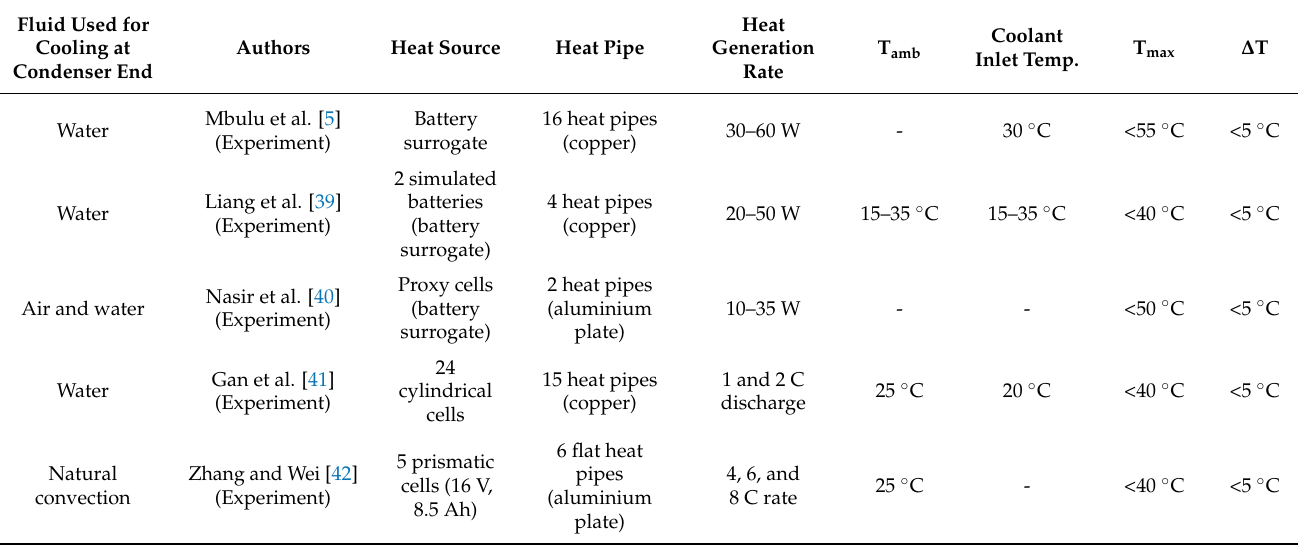
Table 1. Summary of the heat pipe cooling systems reported in the